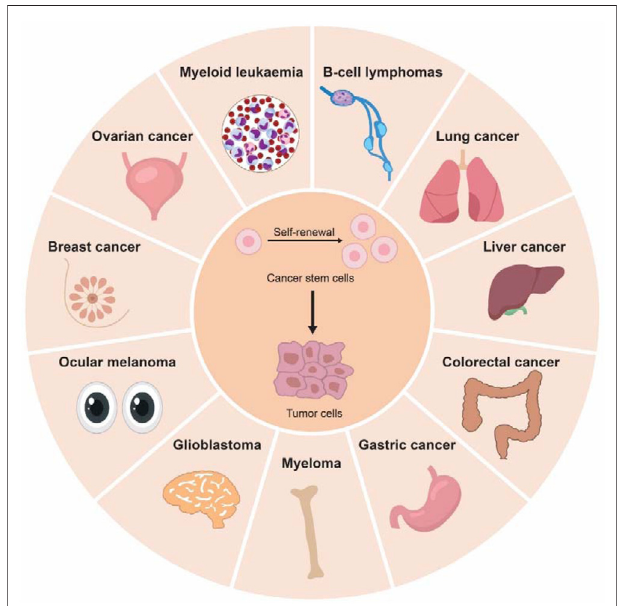
FIGURE 2 | Cancer stem cells are key drivers to tumor initiation and progression. Cancer stem cells(CSCs) have been identi fi edin different type of solid cancers (colorectal cancer, gastric cancer, liver cancer, glioblastoma, melanoma, breast cancer, lung cancer, and ovarian cancer) and hematological cancers (myeloid leukemia, lymphoma, and